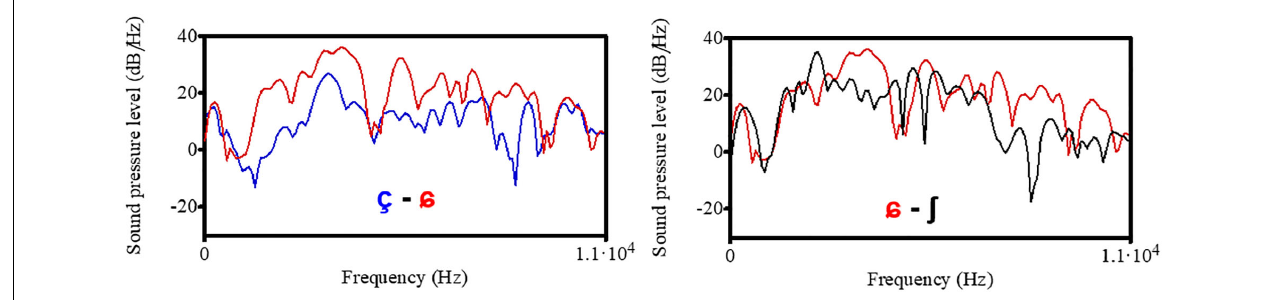
ʃ ] produced by a female speaker of Northern German Standard. Different fricatives are marked by different ɕ years ( SD